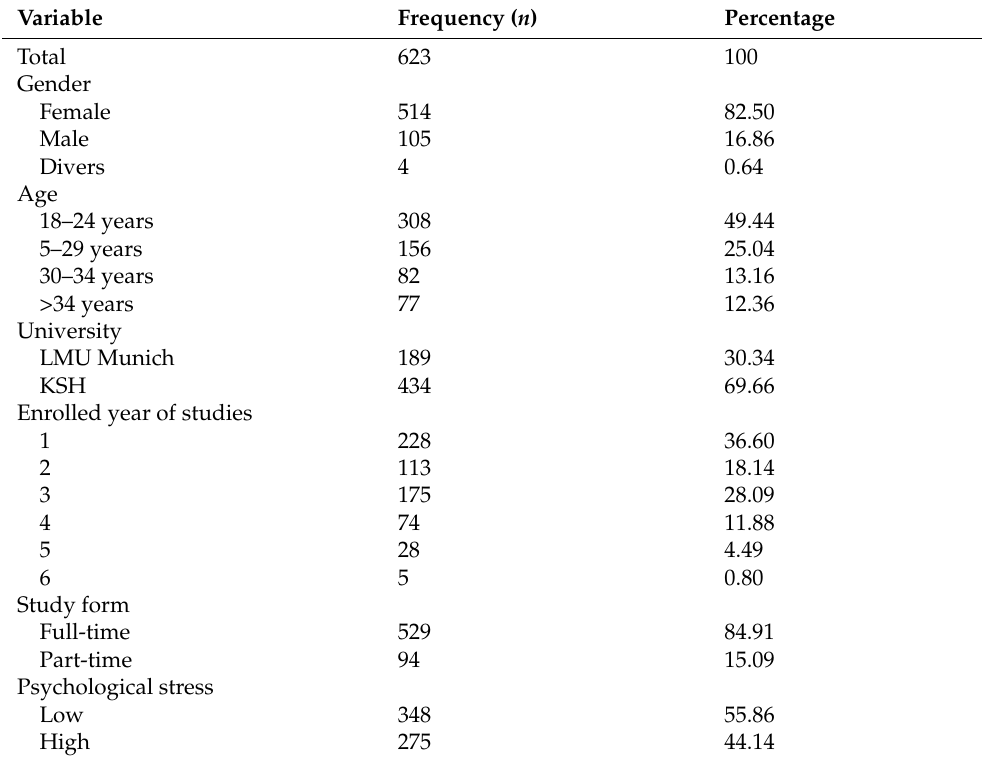
Table 1. Characteristics of the study